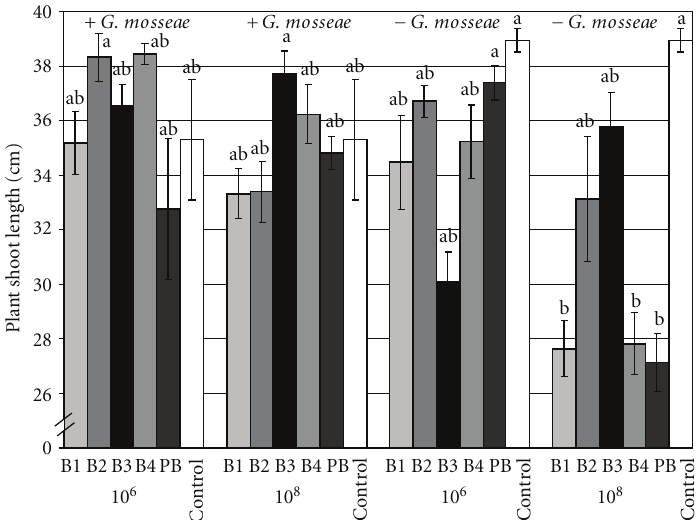
Figure 1: Average lengths of emerged wheat plant shoots, 3 weeks after sowing, inoculated with G. mosseae and/or di ff erent paenibacilli strains (B1–B4 and PB177) at concentrations of 10 6 or 10 8 bacterial cells 10 g − 1 of seeds or left untreated. The same letters above the bars indicate treatments with no significant di ff erences ( P > . 05). Error bars represent the standard error of the mean.